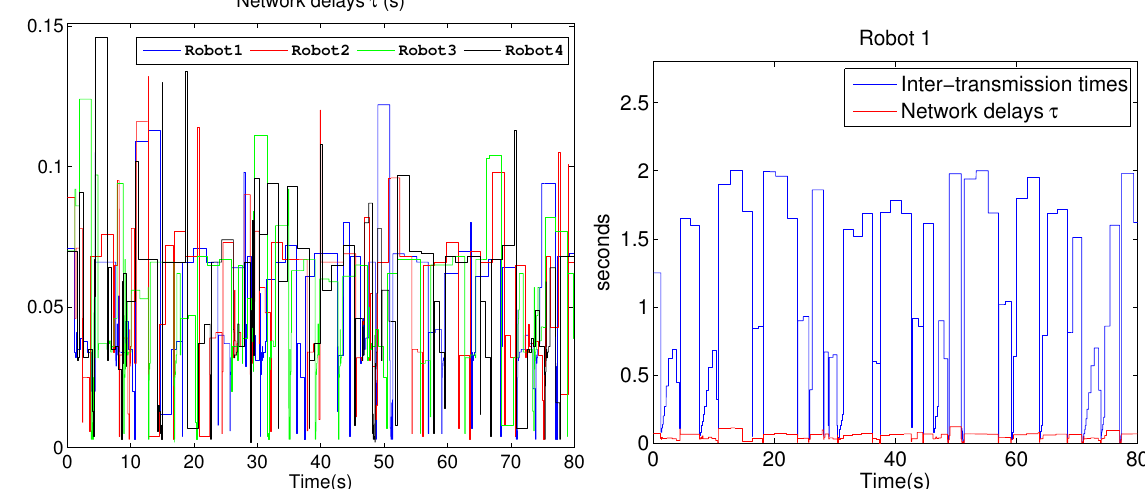
Figure 9. Actual network delays τ registered from the experimental test with four remotely-controlled robots ( Left ) and a detailed representation of the network delays τ and inter-execution times of Robot 1 ( Right